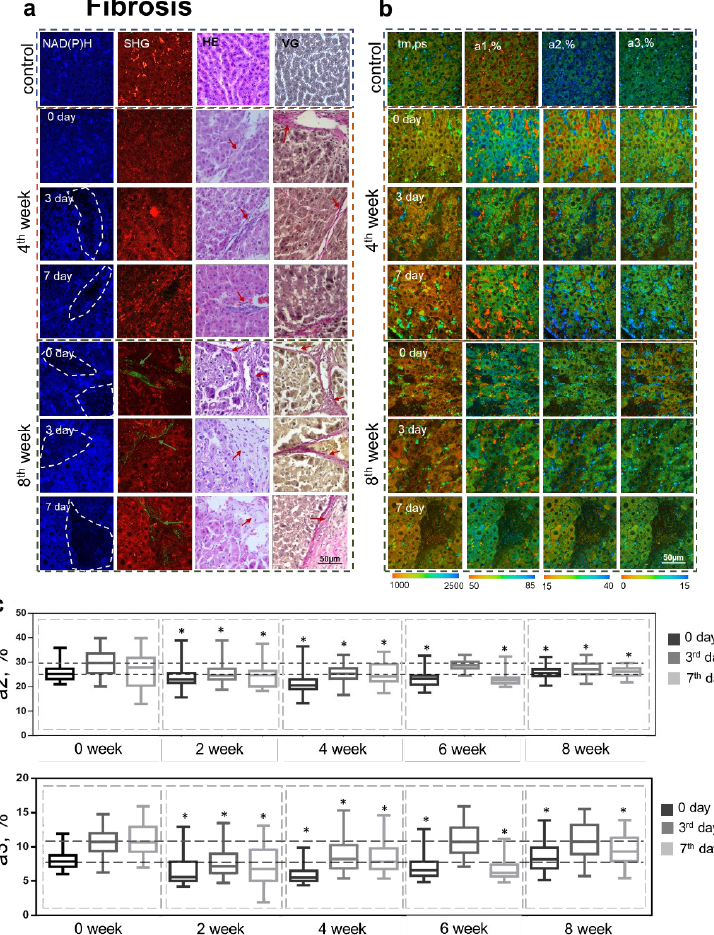
Figure 4. Analysis of the structural and functional state of liver tissue at different stages of fibrosis during induced regeneration. ( a ) Fluorescence intensity images of NAD(P)H autofluorescence (leftmost column); NAD(P)H: excitation at 750 nm, detection range 455–500 nm. Second left column: cell autofluorescence (red): excitation at 800 nm, detection range 433–660 nm, SHG of collagen (green): excitation at 800 nm, detection range 371–421 nm; green arrows indicate collagen. Histological images, hematoxylin and eosin (HE) (second right column) and Van Gieson (VG) (rightmost column) staining; red arrows indicate lipid droplets. ( b ) Pseudo-coded FLIM images at different stages of steatosis during induced regeneration: before PH (0 day) and on the 3rd and 7th days after PH. ( c ) Boxplots reflecting the distribution of the values of the fluorescence lifetime contributions of the bound form of NADH and NADPH. The dotted line marks the medians of the parameter values for normal regeneration; scale bar 50 µ m; × 400. *—statistically significant differences compared to the corresponding time point for normal regeneration, p -value ≤